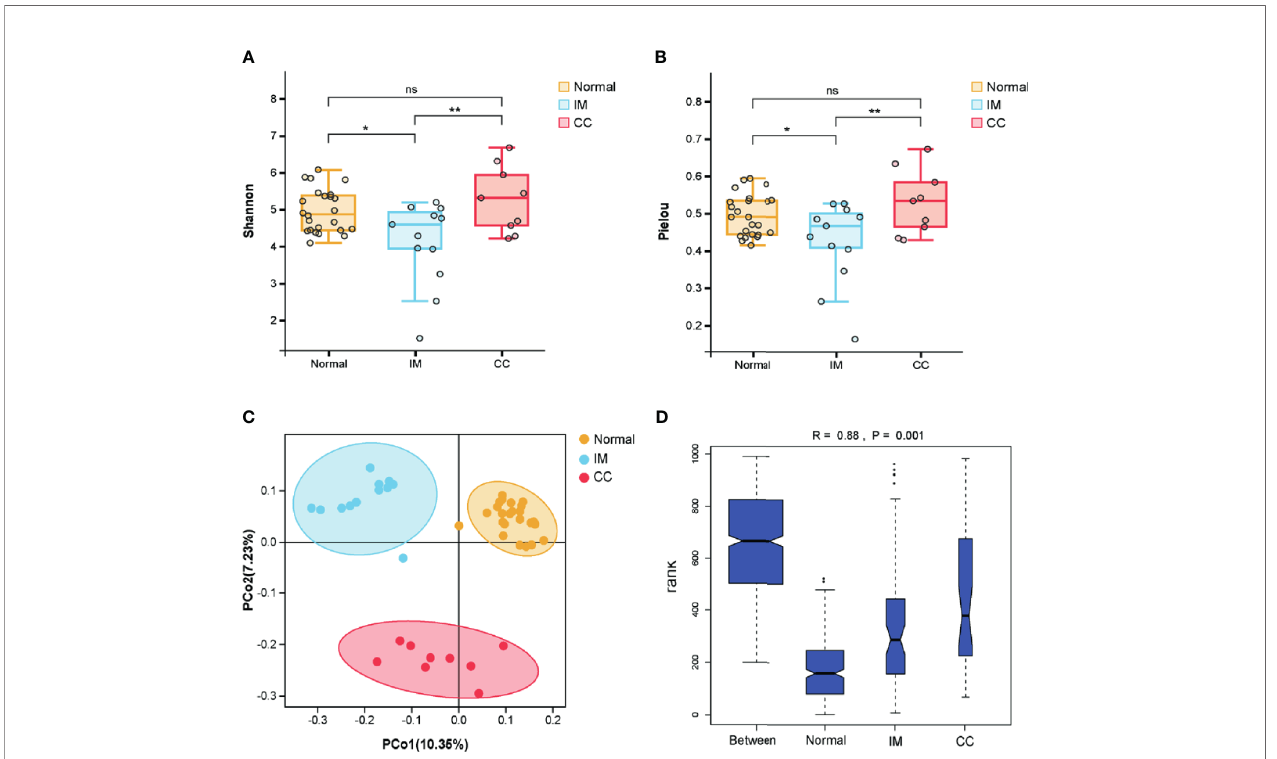
FIGURE 2 | Comparisons of the Microbial Diversity among the IM, CC, and control groups. (A – D) Subjects were divided into three groups, i.e., Normal group (N = 24), IM group (N = 12), and CC group (N = 9). (A, B) As indicated by Shannon diversity index and Pielou evenness index, a -diversity of IM patients was signi fi cantly lower than that of healthy females as well as that of CC subjects. “ * ” means P value < 0.05; “ ** ” means P value < 0.01 and “ NS ” means P value > 0.05. (C) Principle coordinate analysis (PCoA) of unweighted Unifrac distances among the three groups. Points represent samples. The samples in each group were ordinated closely respectively. (D) As tested by ANOSIM, the groups showed signi fi cant differences in similarity (R = 0.88, P ANOSIM =